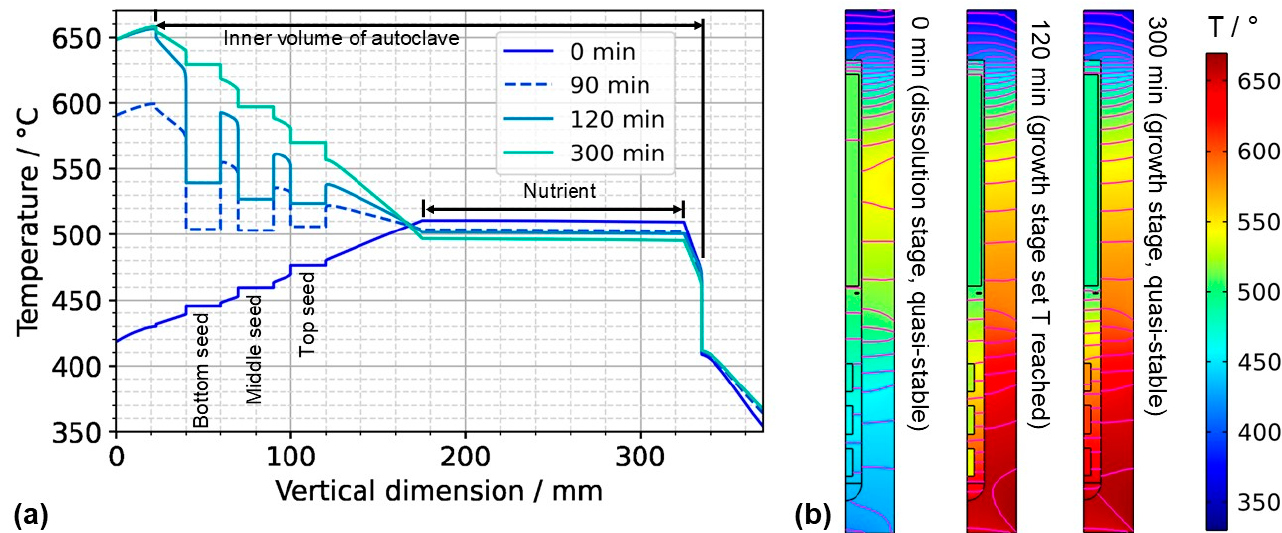
Figure 7. ( a ) Temperature distribution along the centerline for selected points in time. The data labeled with 0 min correspond to quasi-stable conditions at dissolution stage, whereas the data labeled with 120 min correspond to the time at which growth stage set temperatures were reached. The data labeled with 300 min correspond to the time at which quasi-stable conditions at growth stage were reached. The time t = 90 min is also shown, as it represents the time at which all seeds and nutrients have nearly the same temperature. ( b ) Temperature distribution with isotherms for quasi-stable dissolution stage conditions (0 min), at the end of set temperature change (120 min), and for quasi-stable conditions at growth stage (300 min). The temperature difference between isotherms is 10 K, and the range of temperatures is 330 °C to 670 °C.